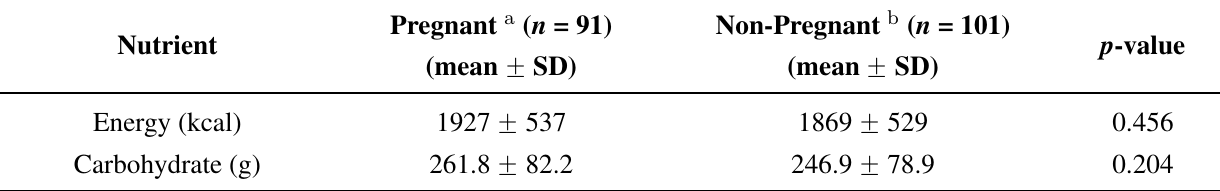
Table 2. Comparison between Groups of Energy and Nutrient Intake Measured by